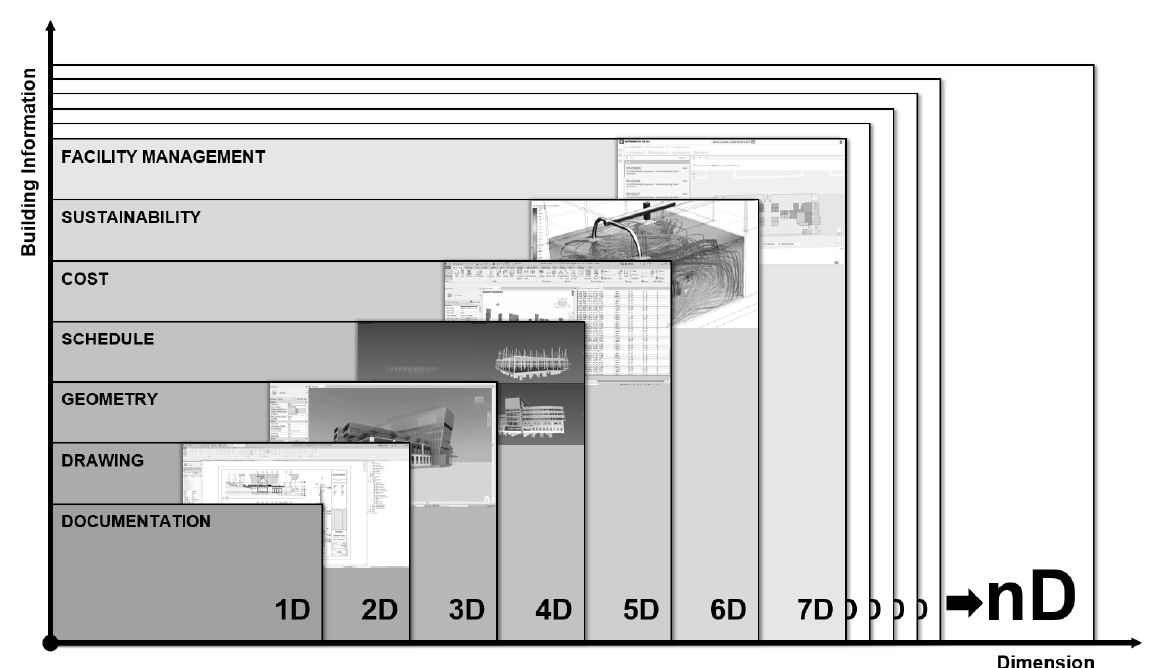
Figure 7. BIM nD Model.